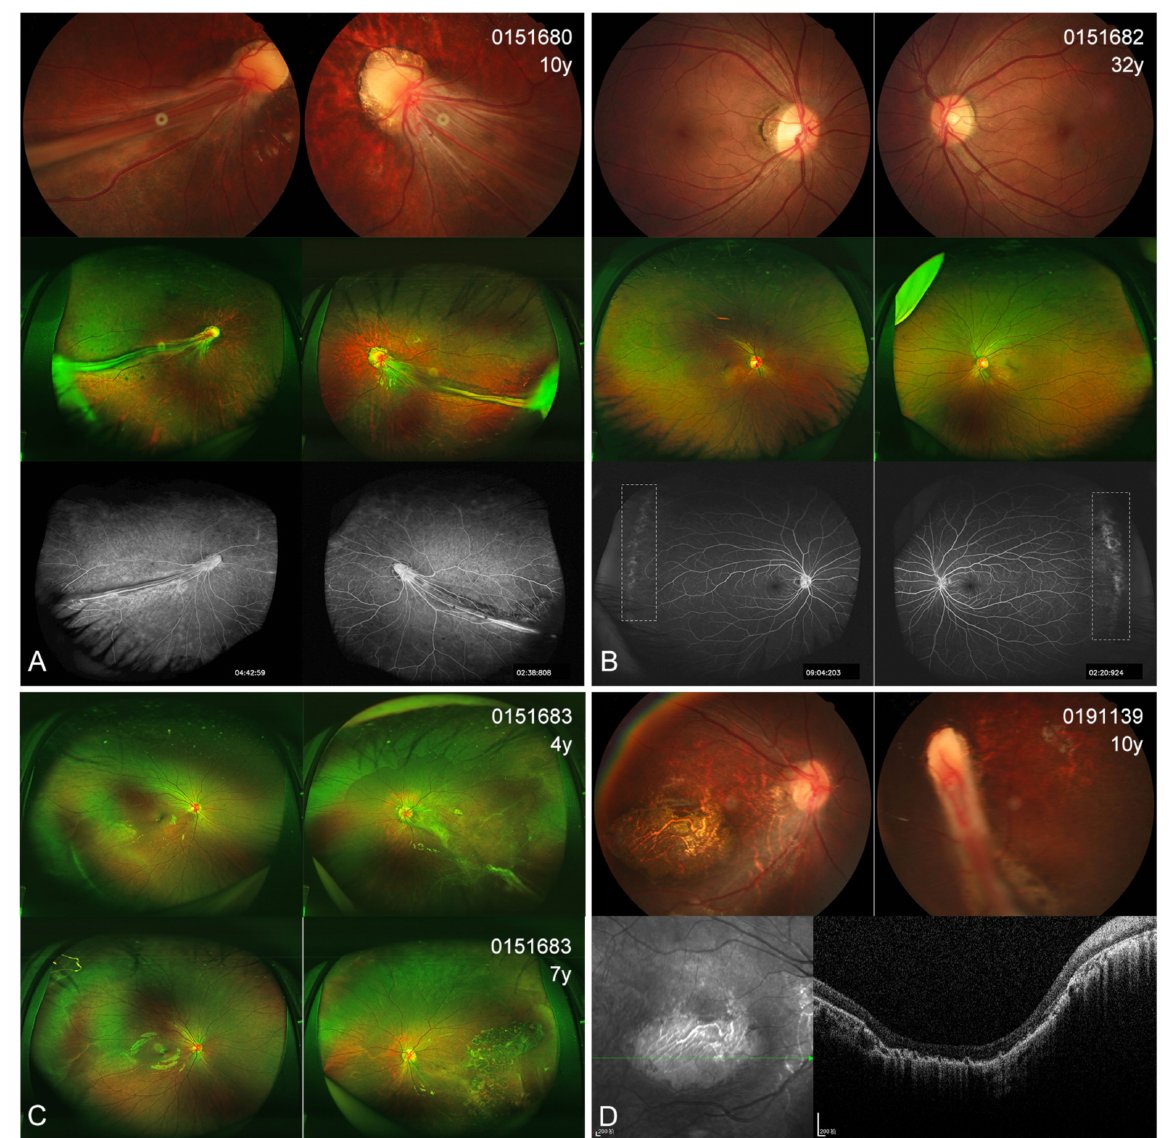
Figure 5. Color fundus (CF), scanning laser ophthalmoscopy (SLO), fluorescein angiography (FA) images, and OCT scans of four patients carrying the variant c.387G>A. ( A ) The CF, SLO, and FA photographs of proband 0151680 show bilateral retinal folds, increases in or straightening of the peripheral vessels (ISPV), and chorioretinal dysplasia. ( B ) The CF and SLO images of mother 0151682 display increased vascular branching, and the FA photographs indicate peripheral avascular zones (white dashed box). ( C ) SLO photographs of sister 0151683 show ISPVs in the right eye, as well as epiretinal membrane and tractional retinal detachment (RD), along with chorioretinal dysplasia in the left eye. Follow-up images 3 years later show that the laser demarcation of an inferotemporal RD on the left eye remained stable. ( D ) CF photographs of patient 0191139 show macular atrophy and a temporally dragged disc in the right eye and a retinal fold in the left. The OCT scan demonstrates severe focal loss of the